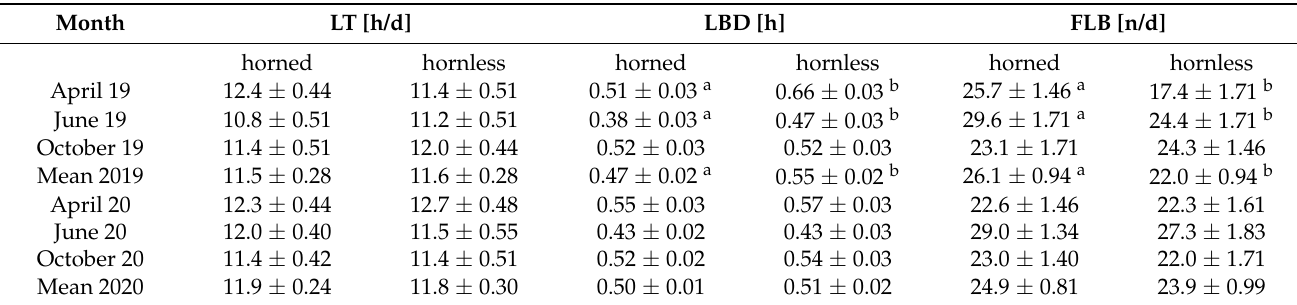
Table 2. Results of the paired Tukey’s t -test (with estimated means and standard error of estimation) divided into horned and hornless goats for mean duration of lying per day (LT), mean lying boat duration per day (LBD) and mean frequency of lying boats per day